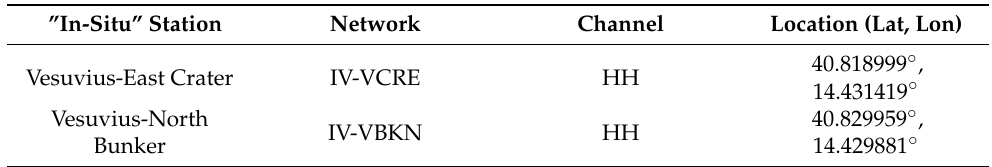
Table 2. Characteristics of the “in situ” seismographs. ”In-Situ” Station Network Channel Location (Lat,